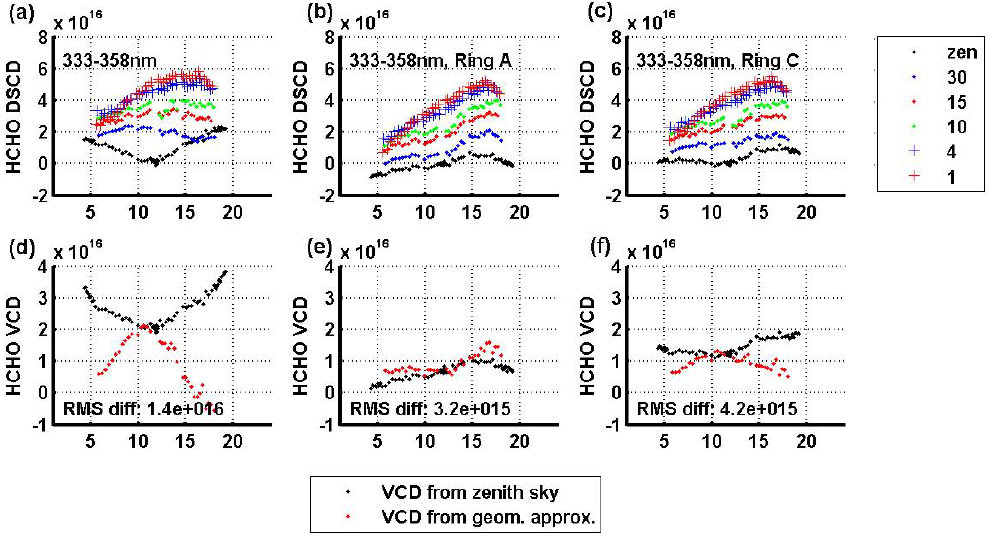
Fig. 16. Same as Fig. 9, but for an analysis in the 333–358nm wavelength region, with a 5th order polynomial and the O 4 Greenblatt et al. (1990) data set, and for different choices of the Ring cross sections. Both DSCDs and VCDs are expressed in moleccm − 2 .